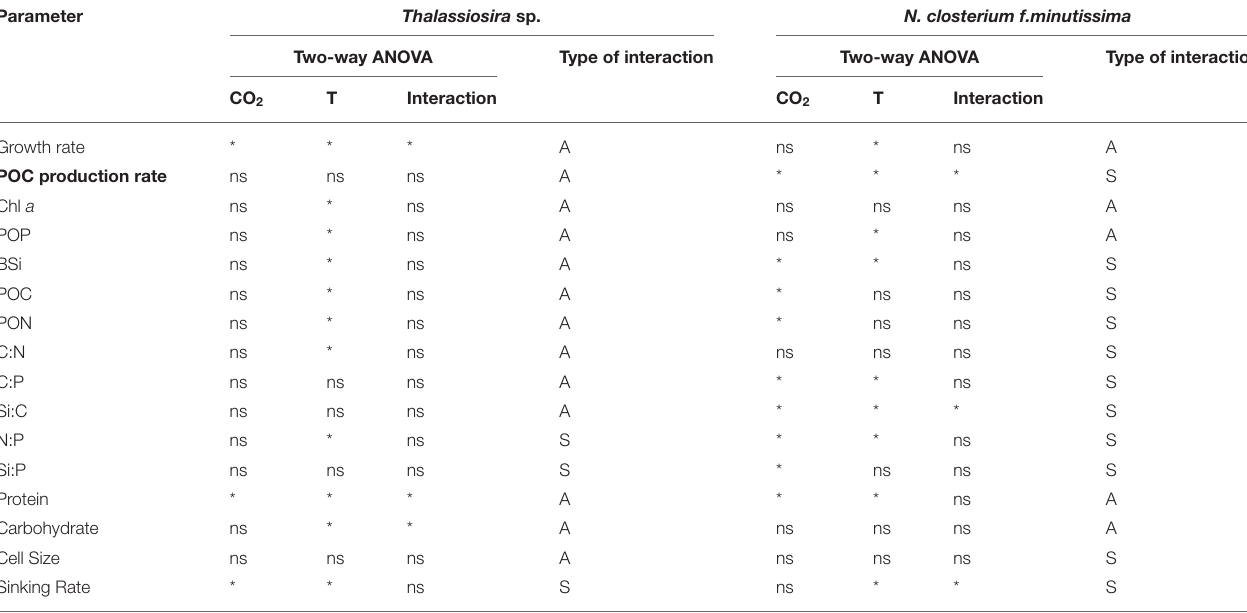
TABLE 3 | Interactive effects of CO 2 and temperature on the physiological parameters of Thalassiosira sp. and N. closterium f.minutissima . Parameter